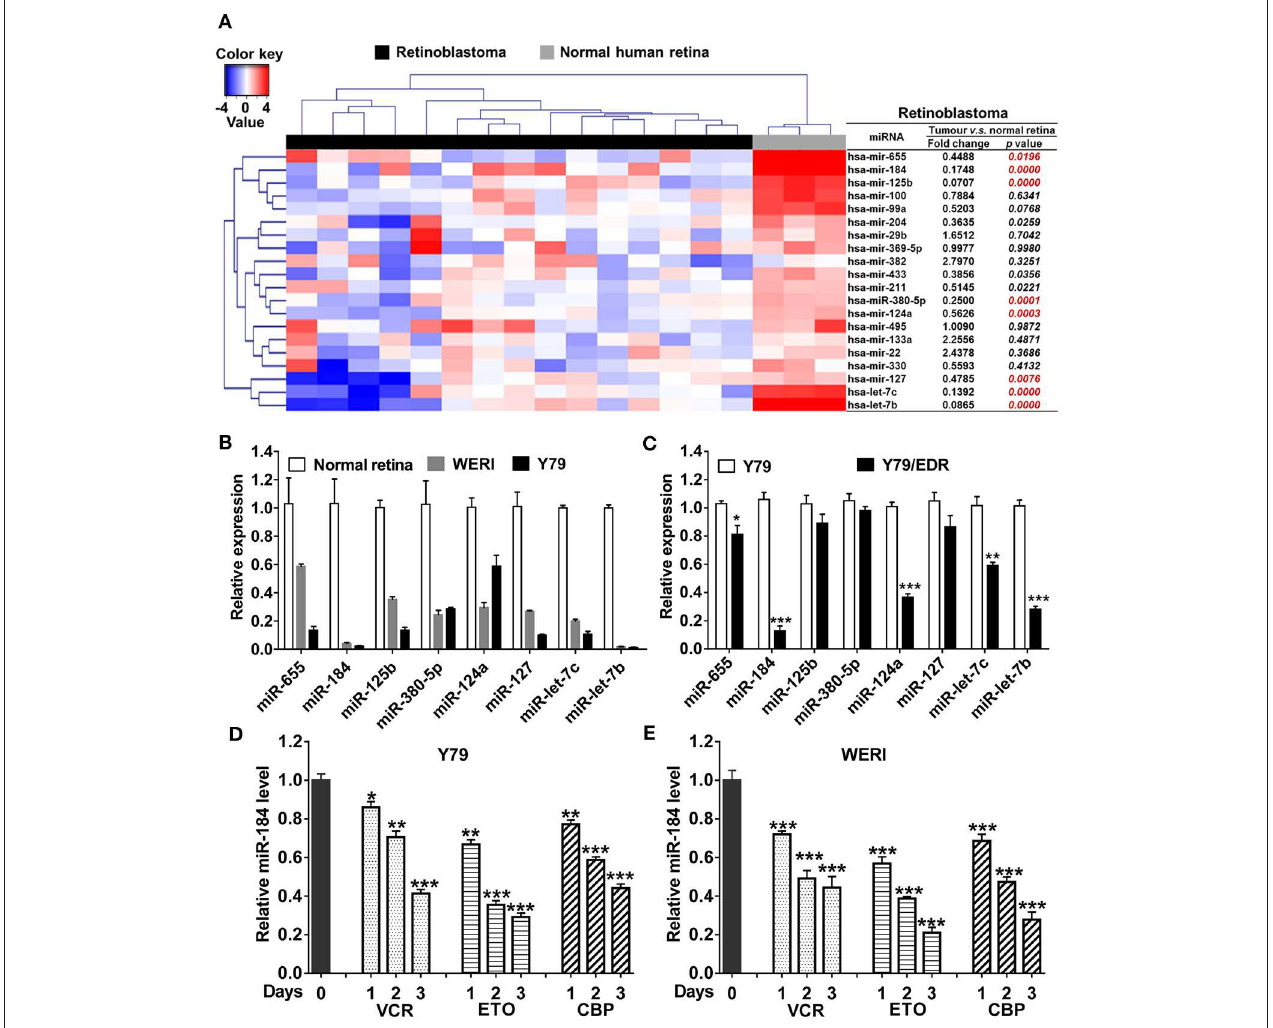
FIGURE 1 | miR-184 is a chemosensitive miRNA in retinoblastoma (RB). (A) Expression heatmap of top 20 decreased miRNAs identified by miRNA array in previous studies, which were selected and detected by qRT-PCR in 15 human RB tissues. (B) Expression of miRNAs in normal retina (three samples), WERI, and Y79 cells was detected by qRT-PCR. (C) Expression of miRNAs in Y79 and Y79/EDR was detected by qRT-PCR. qRT-PCR of miR-184 expression in Y79 cells (D) and WERI cells (E) treated with VCR (2.5nM), ETO (0.25 µ M), or CBP (1 µ M). Data were presented as mean ± SD of three independent experiments. * P < 0.05, ** P < 0.01, *** P < 0.0001 vs. control